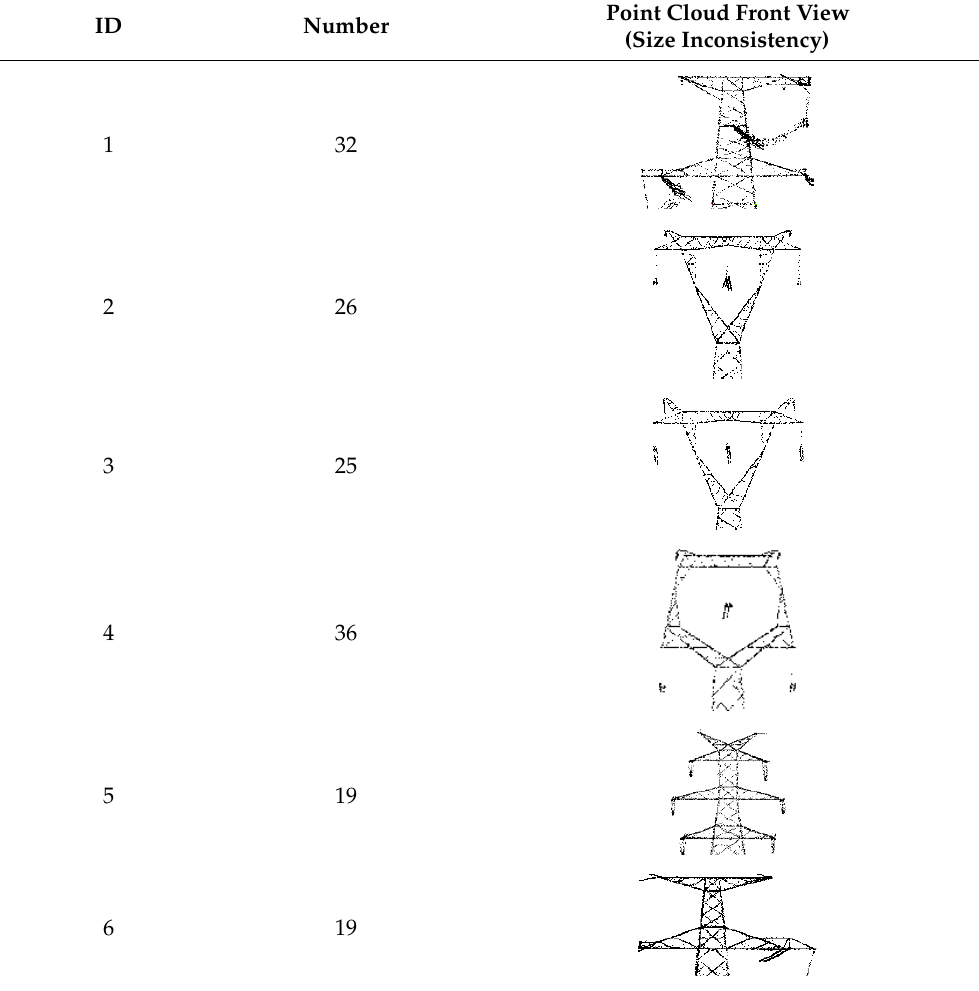
Table 2. The number of six types of transmission towers.